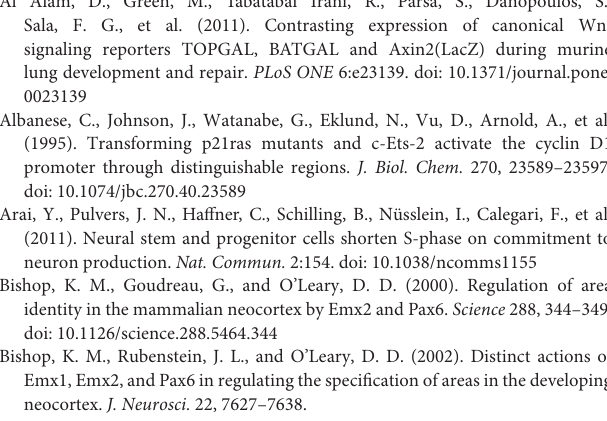
Figure S1 | Predicted SP8 binding sites on Ccnd1 Ex1 fragment. The predicted SP8 sites from Table S4 (A–G) , the SP8 summit (SP8S), the PAX6 summit